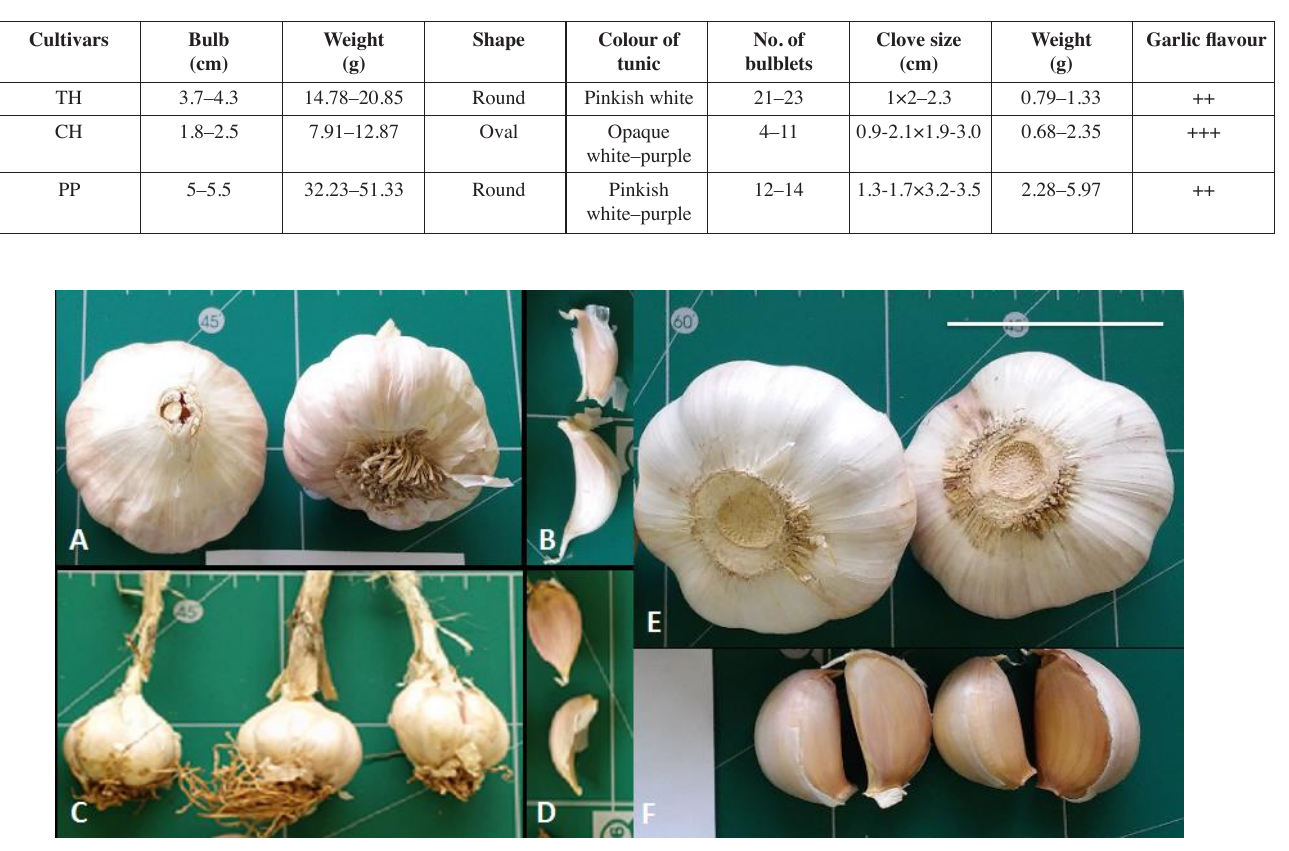
Fig. 1: Garlic bulb and bulblets of A. sativum L. cv. Thai (A-B), cv. Chinese (C-D) and cv. Pingpong (E-F). Scale bar = 5 cm.